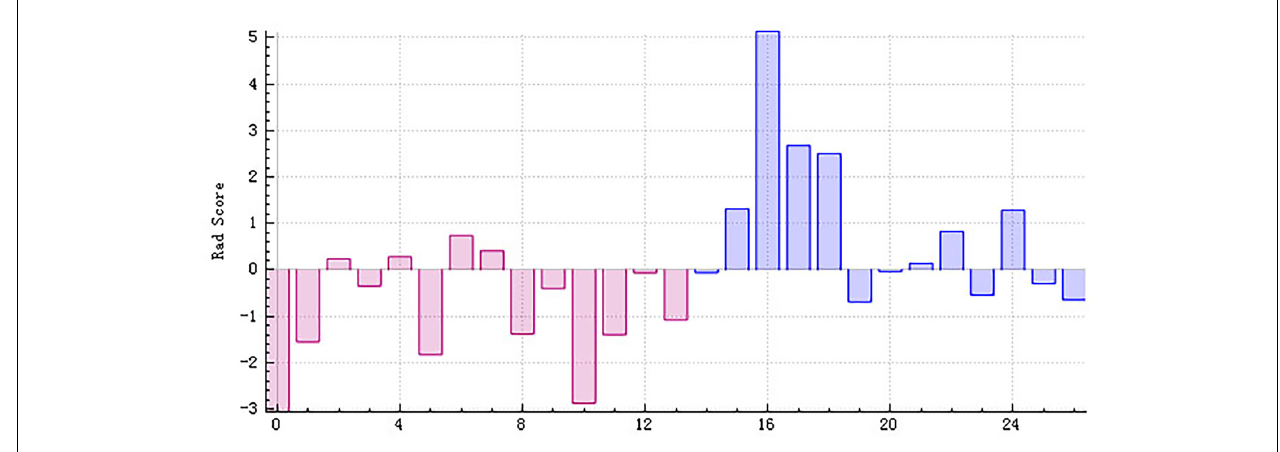
FIGURE 9 | The radiomics score based on testing data of the left hippocampus. Red represents the normal group, and blue represents the patient group. The red area below the horizontal line and the blue area above the horizontal line represent the right prediction. On the contrary, the red area above the horizontal line and the blue area below the horizontal line represent the false